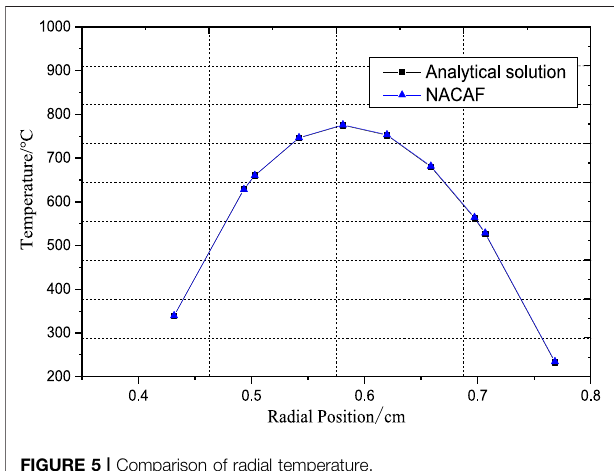
FIGURE 5 | Comparison of radial